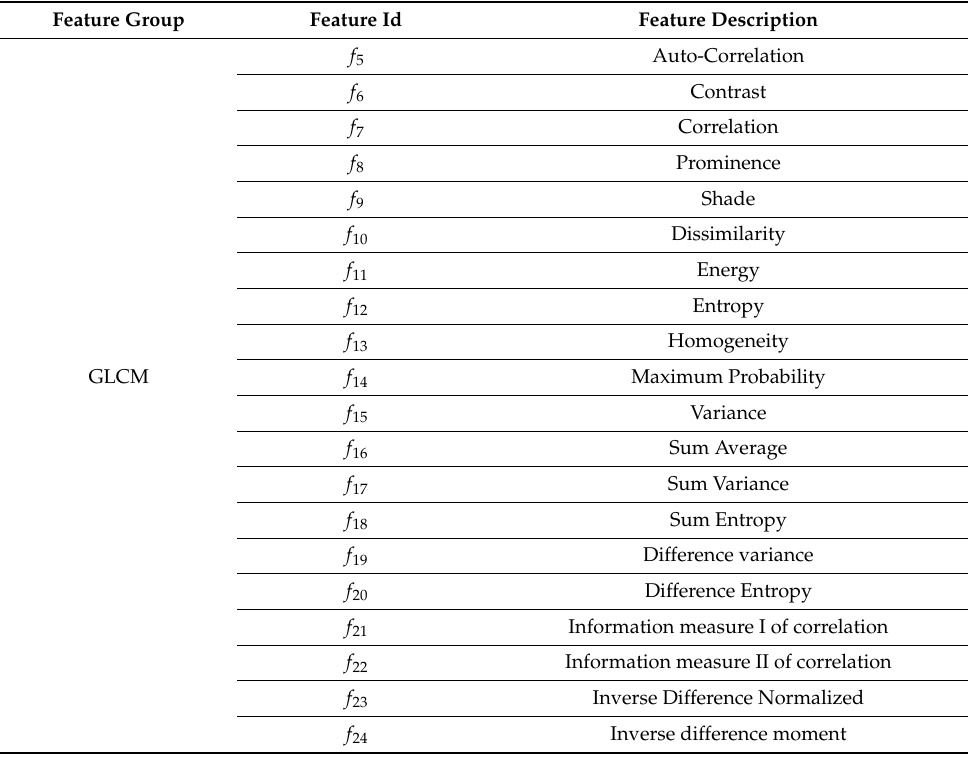
Table A1. Definition of gray-level co-occurrence matrix (GLCM) descriptors.